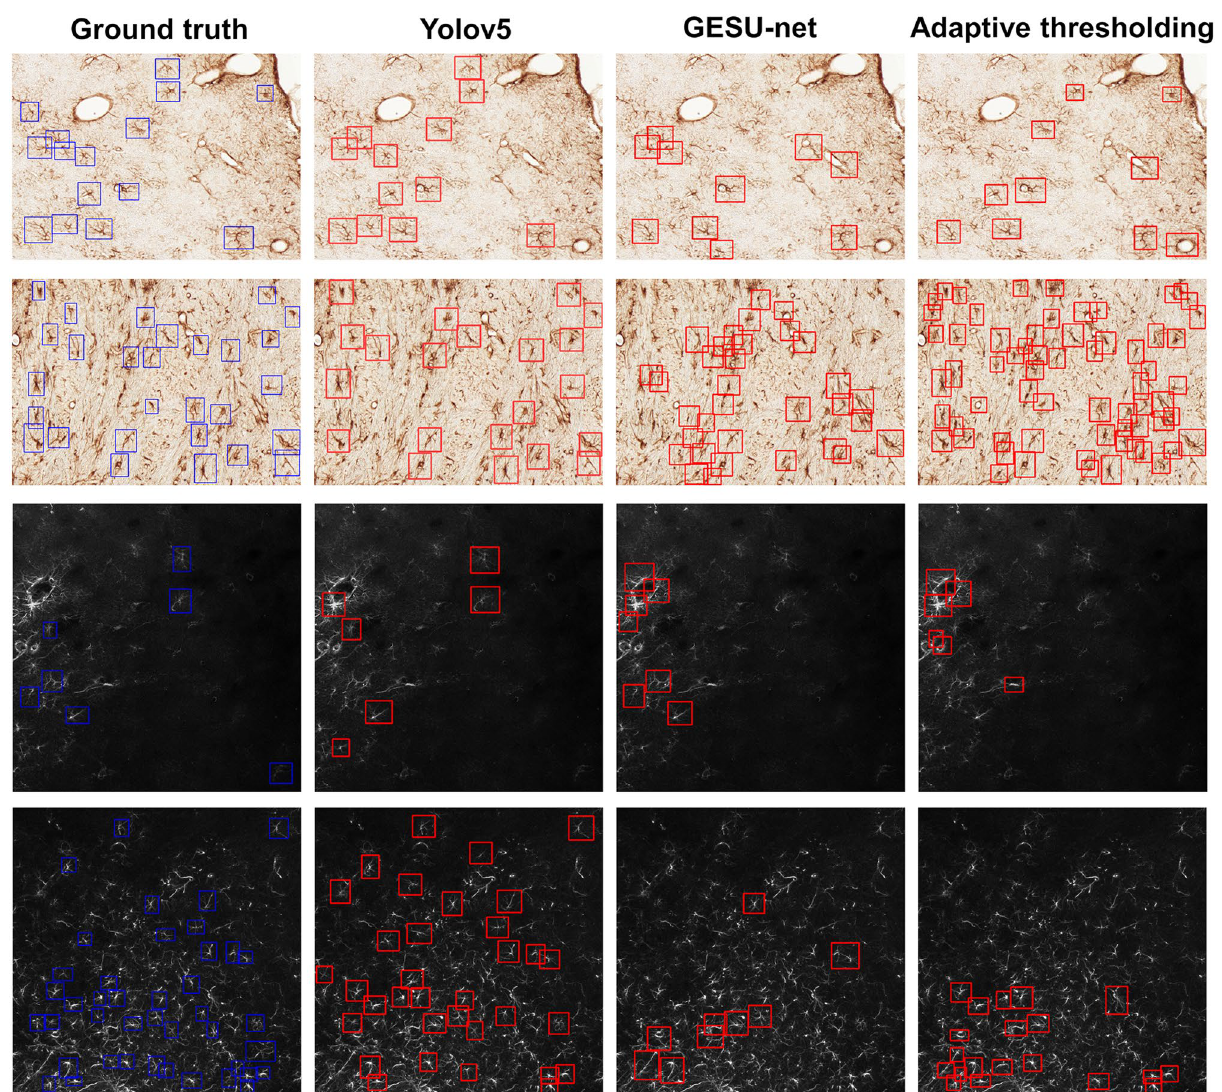
Figure 4. Detection performance. Astrocyte detection performance using different algorithm is shown on two representative images from the BBBC dataset (top two rows) and two representative images from the Kruyer dataset (bottom two rows). The first column shows the ground truth images, the second column shows the corresponding detection results of using our algorithm based on YOLOv5 (with probability threshold 0.47), the third column shows the detection result of the GESU-net algorithm and the fourth column shows the detection result using Adaptive thresholding implemented in